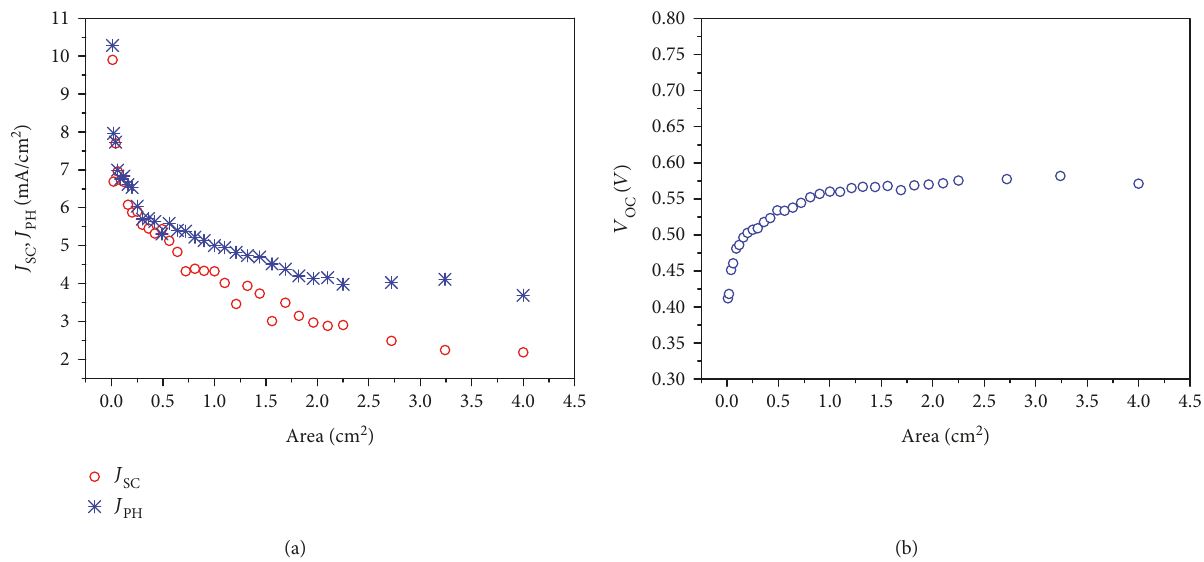
Figure 3: (a) Extrapolated short-circuit current and simulated photocurrent from the device. (b) Open-circuit voltage of the device regarding the measured active